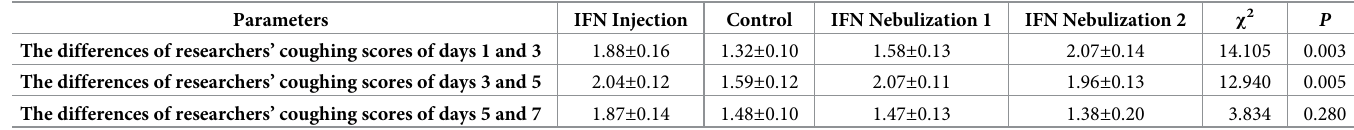
Table 4. The comparisons for the differences in coughing scores as assessed by the researchers among the four groups by the Kruskal—Wallis test.